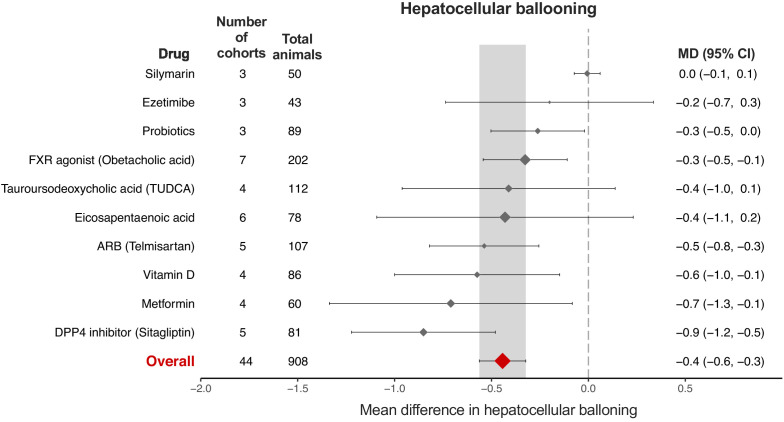
Meta-analysis of hepatocellular ballooning in rodent studies of NAFLD by individual drug.Forest plot with subgrouping by individual drug. Individual studies have been hidden and only subgroup summaries are illustrated. Total animals is the sum of control and interventional animals for each subgroup. ARB, angiotensin receptor blocker; CI, confidence interval; DPP4, Dipeptidyl peptidase-4; FXR, Farnesoid X receptor; MD, mean difference; TUDCA, tauroursodeoxycholic acid.